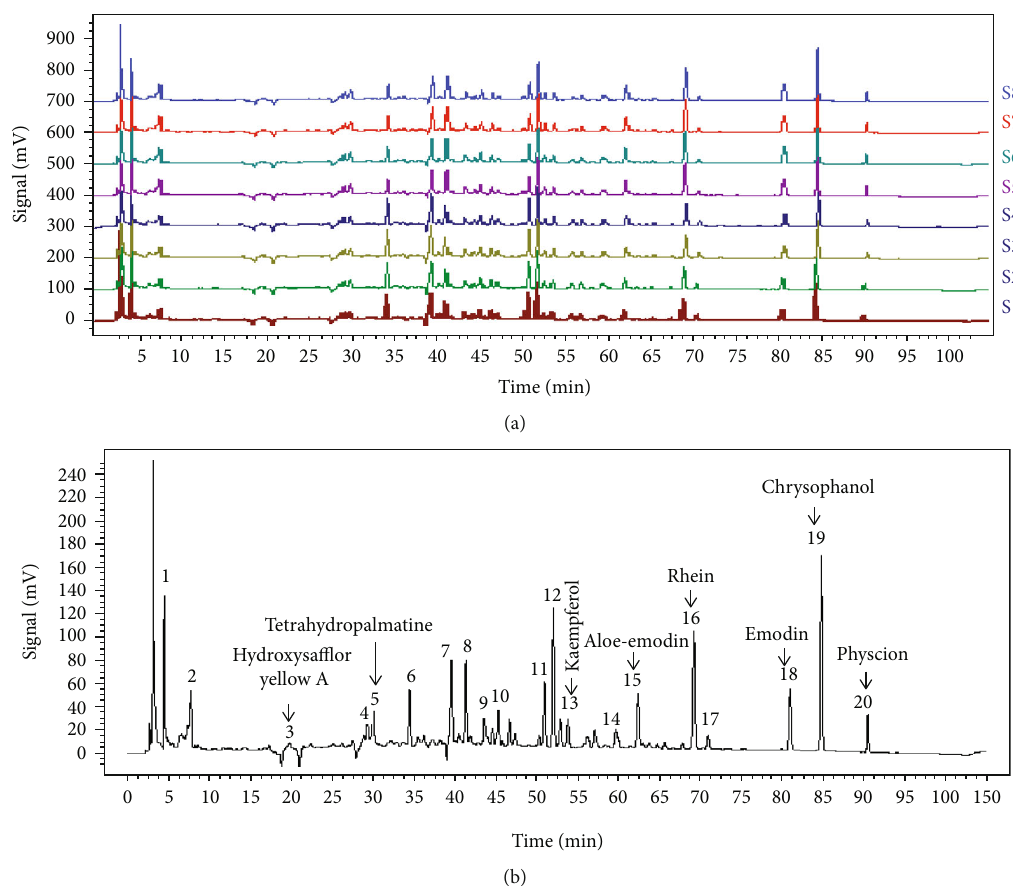
Figure 1: Fingerprints of HuoXueTongFu Formula (HXTF): (a) chromatographic fi ngerprints of eight samples of HXTF (S1 – S8) and (b) the typical chromatographic fi ngerprint for HXTF. The 8 common peaks are